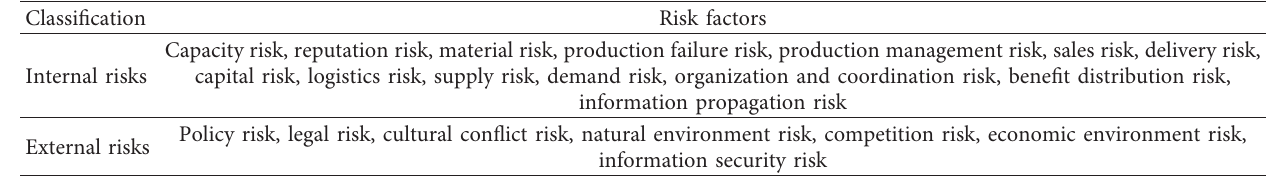
Table 1: Risk factors of supply chain.